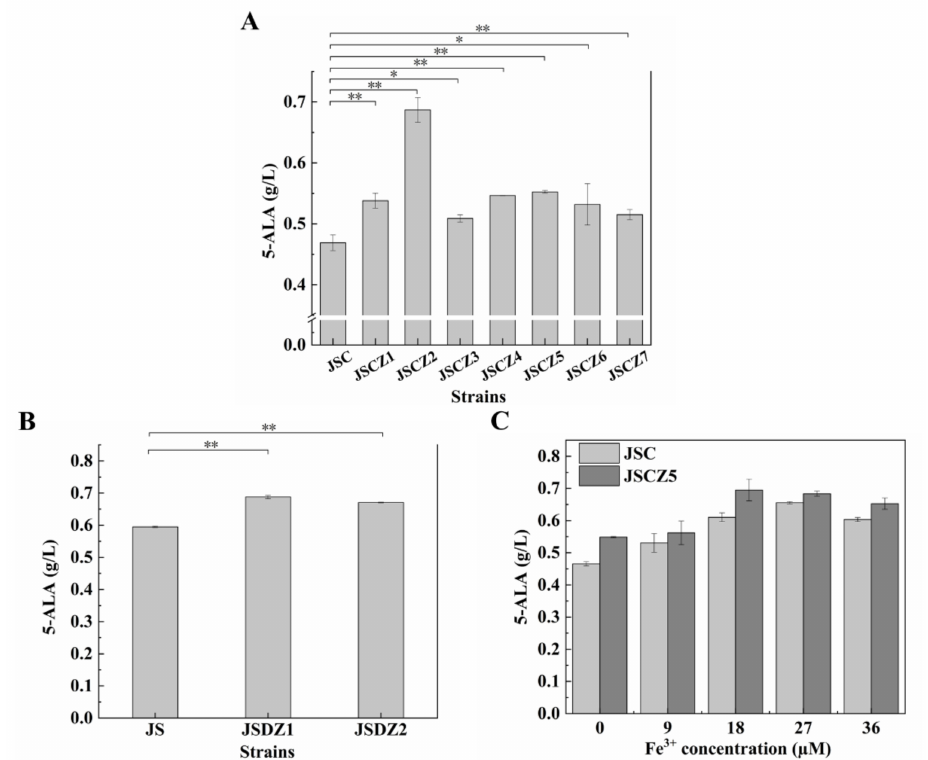
Figure 5. Functional validation of key DEGs affecting 5-ALA biosynthesis in JSD1. ( A ) The effects of overexpression of individual genes including NCgl1445 (JSCZ1), iolT1 (JSCZ2), pyk2 (JSCZ3), aceA (JSCZ4), afuABC (JSCZ5), pstSCAB (JSCZ6), and ugpQ (JSCZ7) on 5-ALA biosynthesis compared to JSC. ( B ) The effects of the individual deletions of gdhA and sdhCAB on 5-ALA biosynthesis